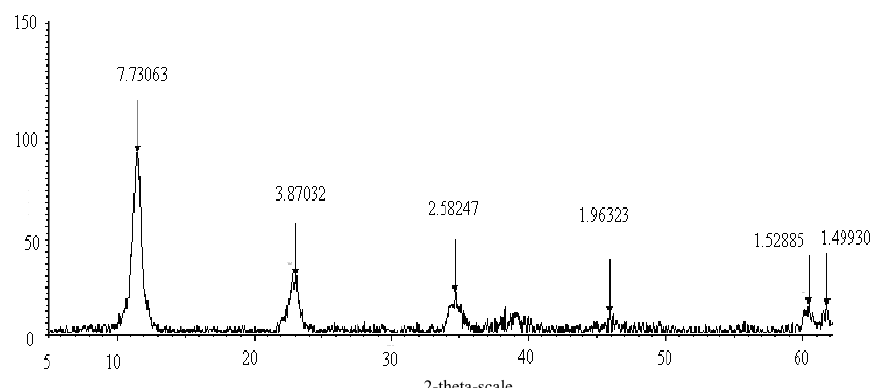
Figuire 2a. The diffraction spectra of the noncalcinated